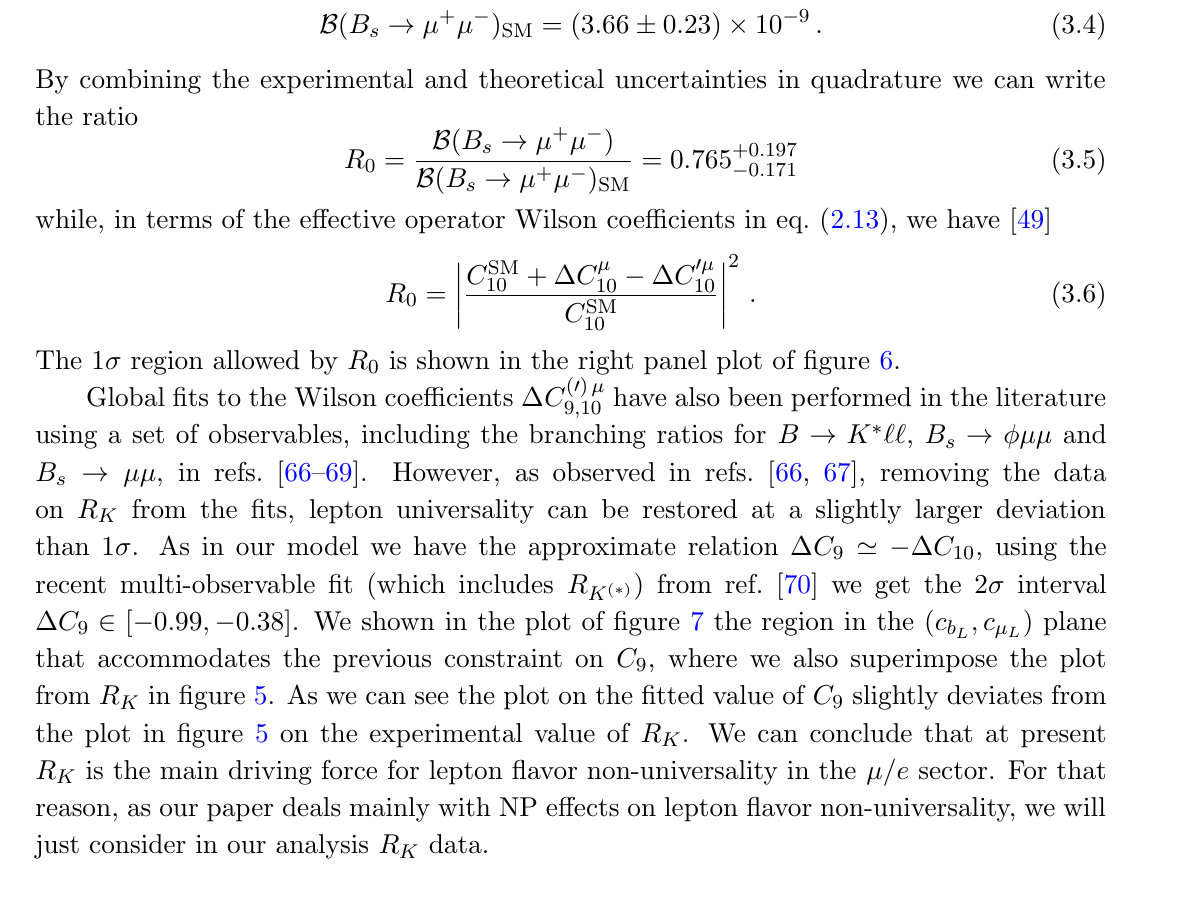
Figure 6 . Left panel: region in the plane ( c b (cid:22) Kee ) given by eq. (3.1). Right panel: region in the plane ( c ( (cid:22) B B ! 1 (cid:27) region R 0 [0 : 594 ; 0 : 2